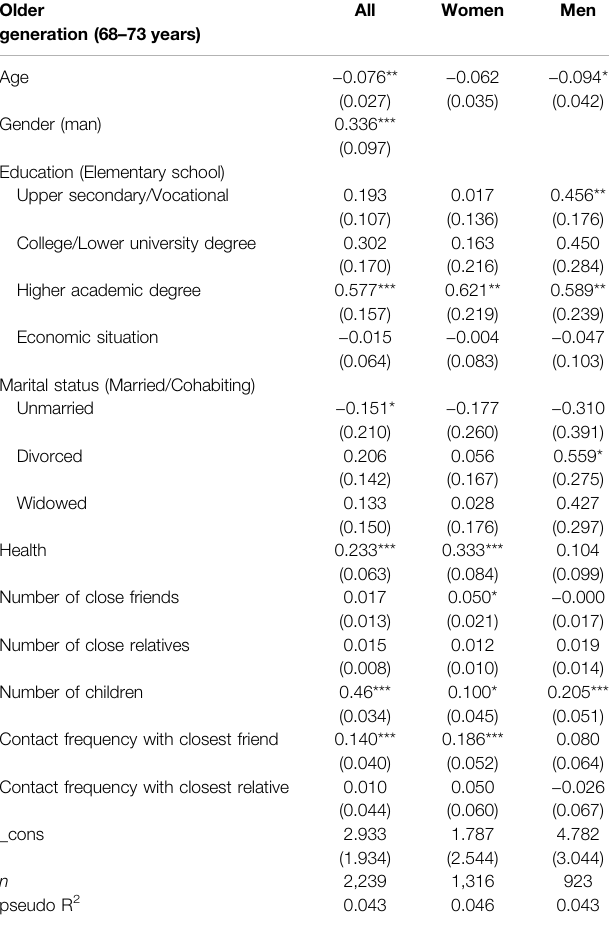
TABLE 2| PredictorsofsocialmediauseinolderFinnishadults(born1945 – 1950) ( n (cid:1) 2,663). β -coef fi cients and (standard errors). Older generation (68 – 73 years)